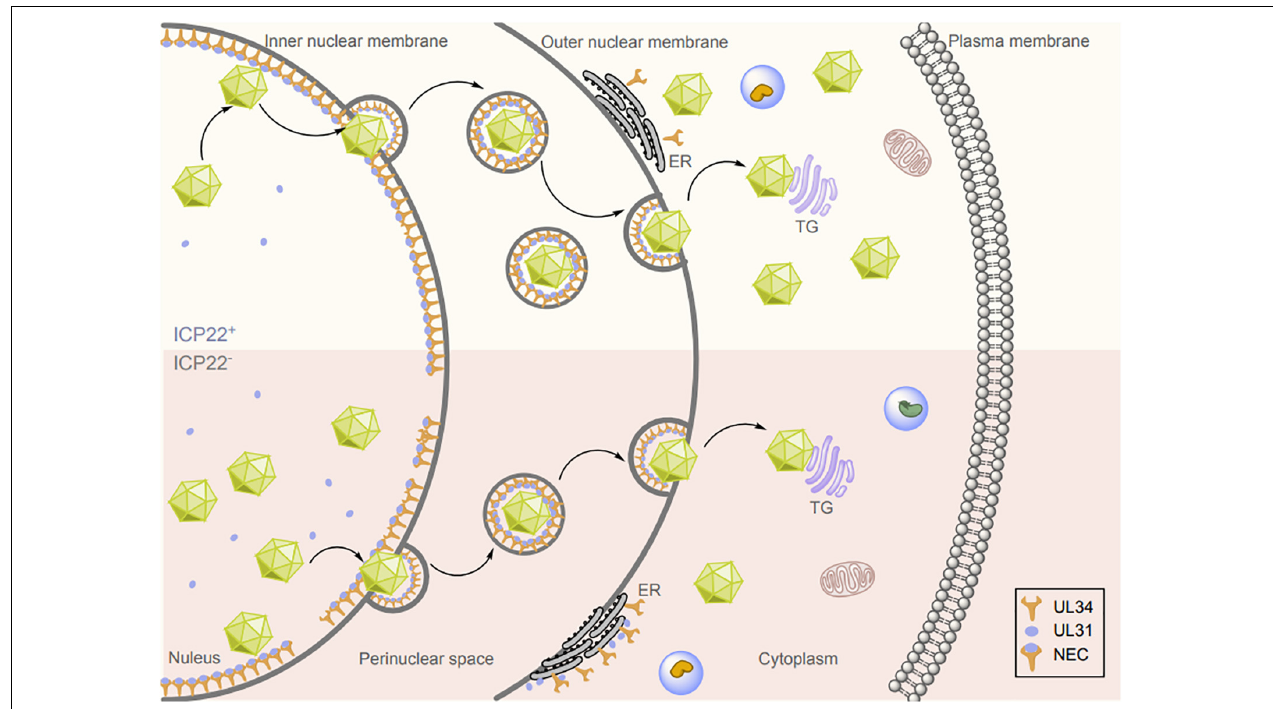
FIGURE 3 | Effects of ICP22 on herpesvirus nuclear budding. Herpesvirus nucleocapsid assembly is completed in the nucleus, and the nucleocapsid is then translocated by budding from the INM to the perinuclear region via the NEC, where it fuses with the ONM to complete the budding and release process. ICP22 promotes HSV-1 nuclear budding by interacting with and regulating UL31 and